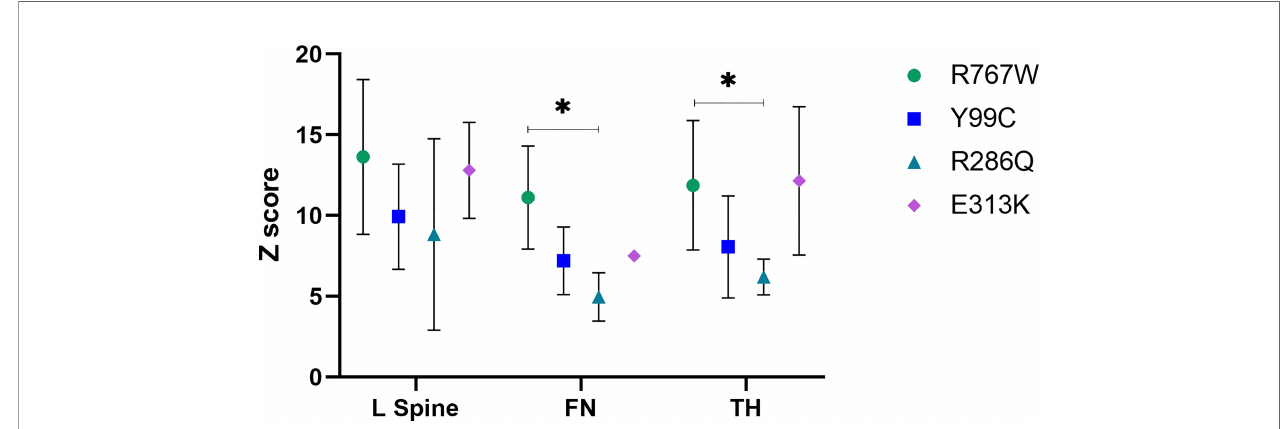
FIGURE 3 | Central DXA measurements in ADO > subjects with four mutations and the relationship between mutations and BMD at lumbar spine and hip sites. *means p<0.05. L spine, Lumbar spine; FN, femoral neck; TH, Total hip.